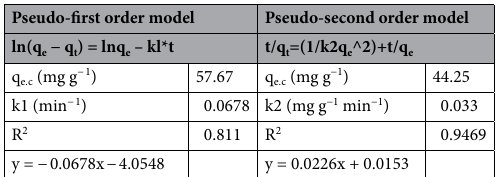
Table 2. Kinetic parameters for the adsorption of MB dye on PAK.